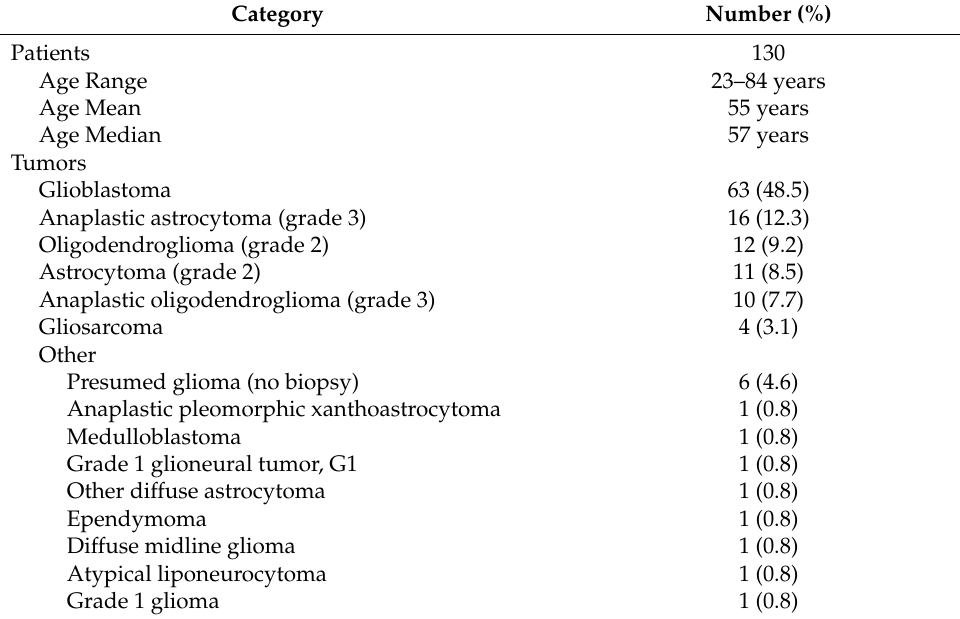
Table 2. Patient and Tumor